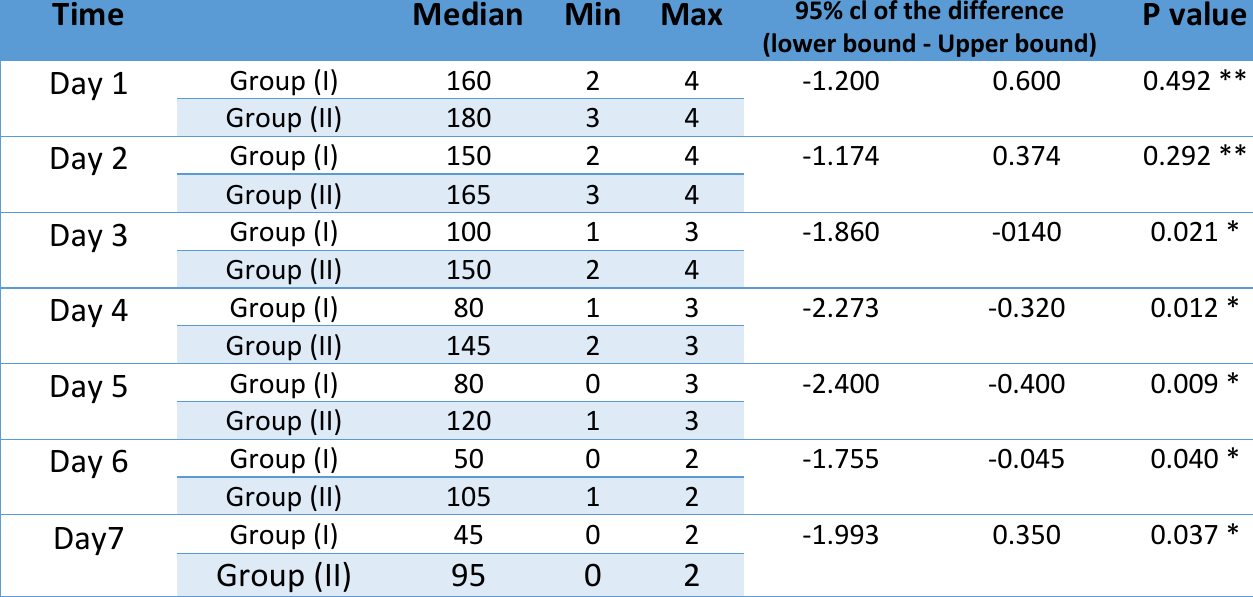
Table 2. Median and range values of analgesic consumption (mg) daily.